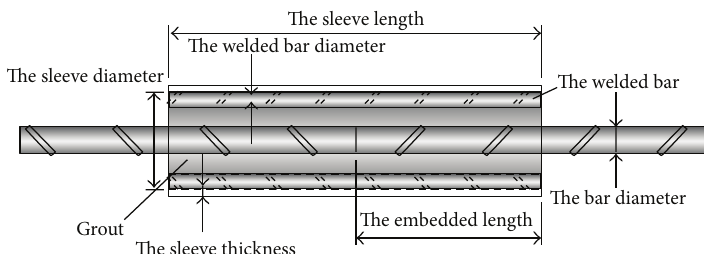
Figure 1: A typical grouting connected steel bar using steel sleeve.